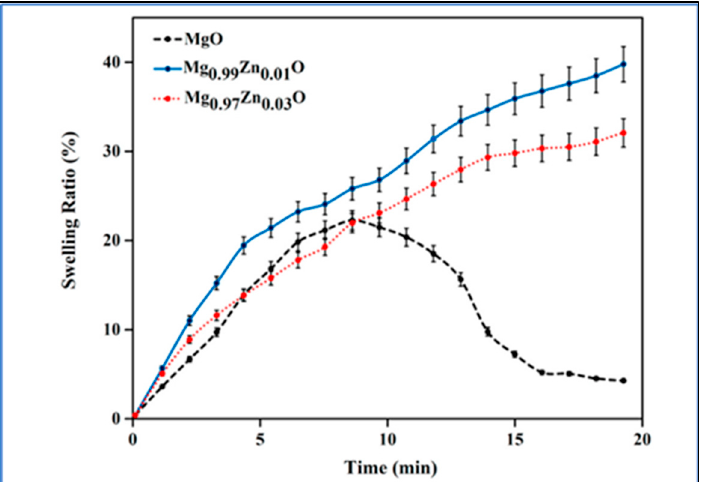
Figure 6. Swelling capacity of the kappa-carrageenan nanocomposite hydrogels containing MgO,